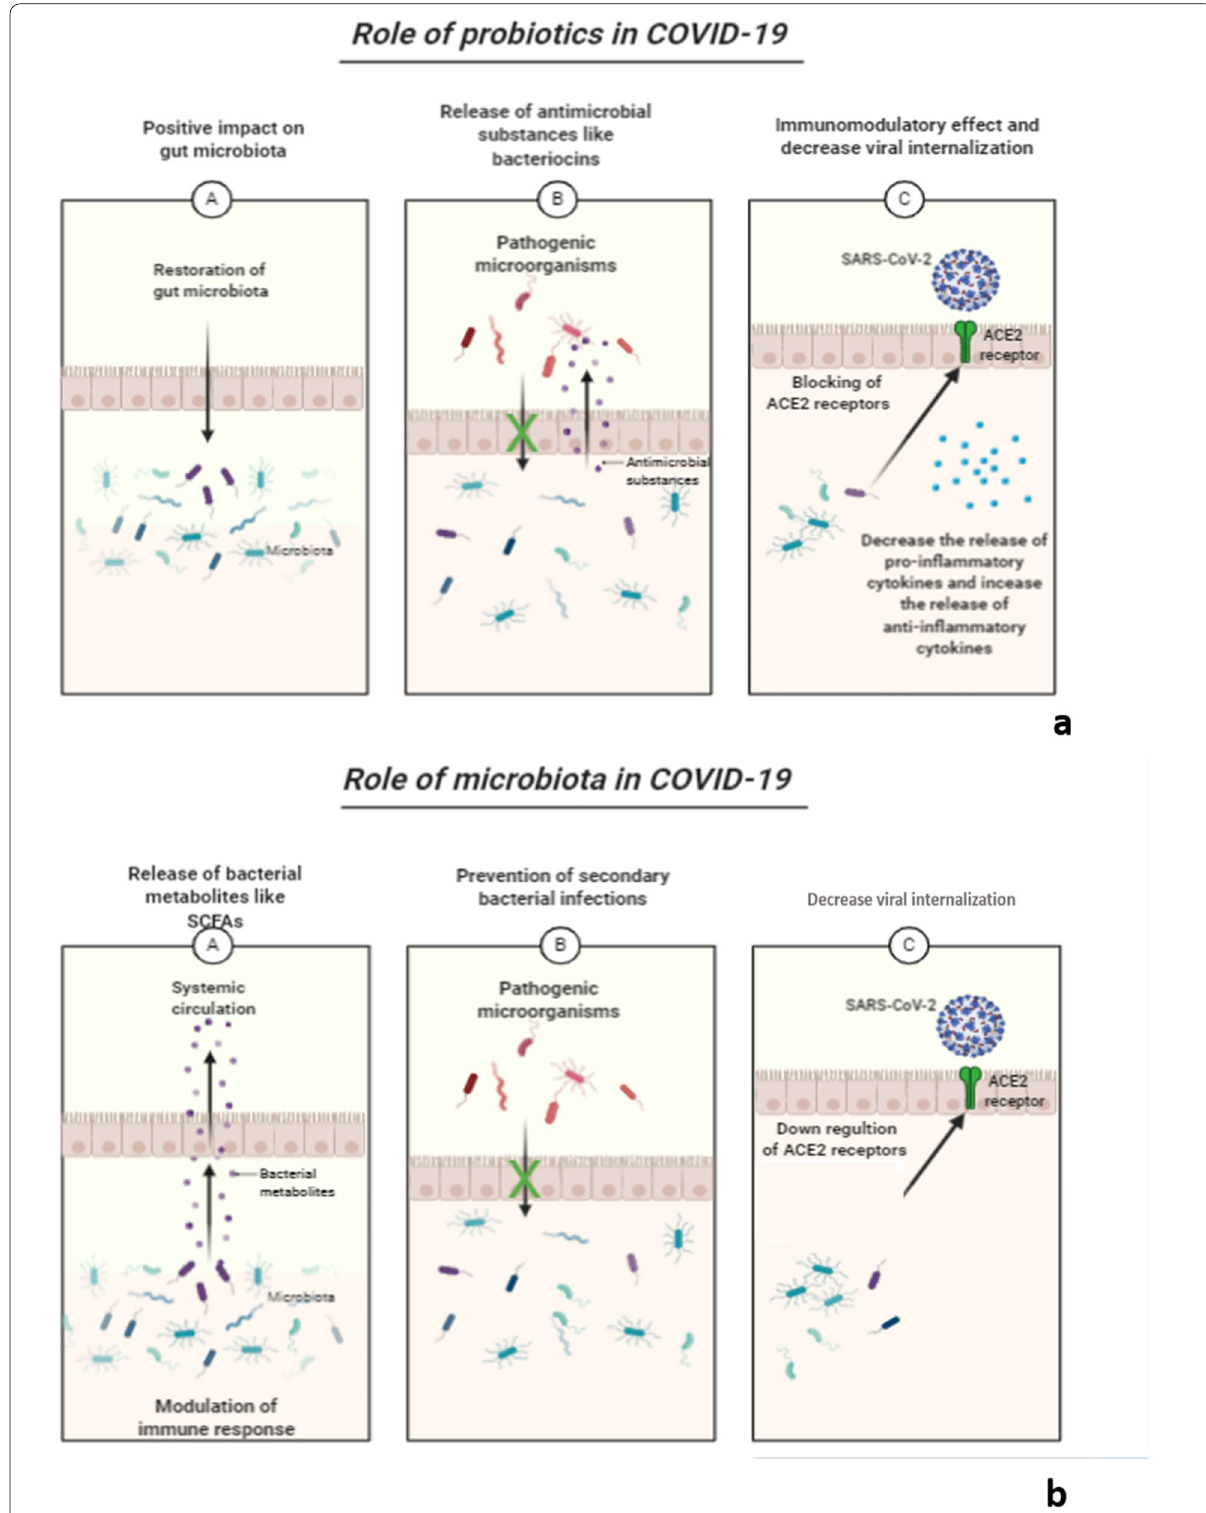
Fig. 1 Role of a probiotics and b microbiota in treatment of